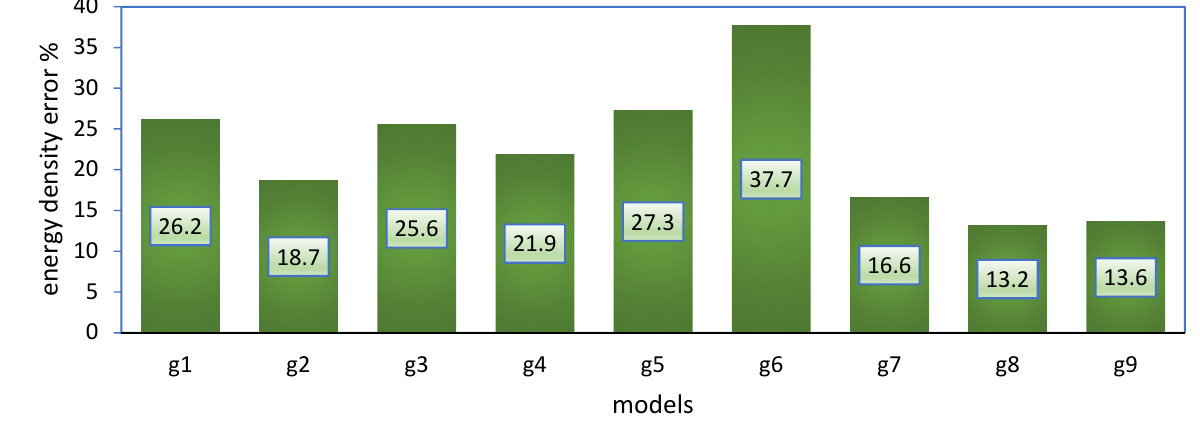
Figure 10. Energy density error of the nine models for Shark El-Ouinate site.